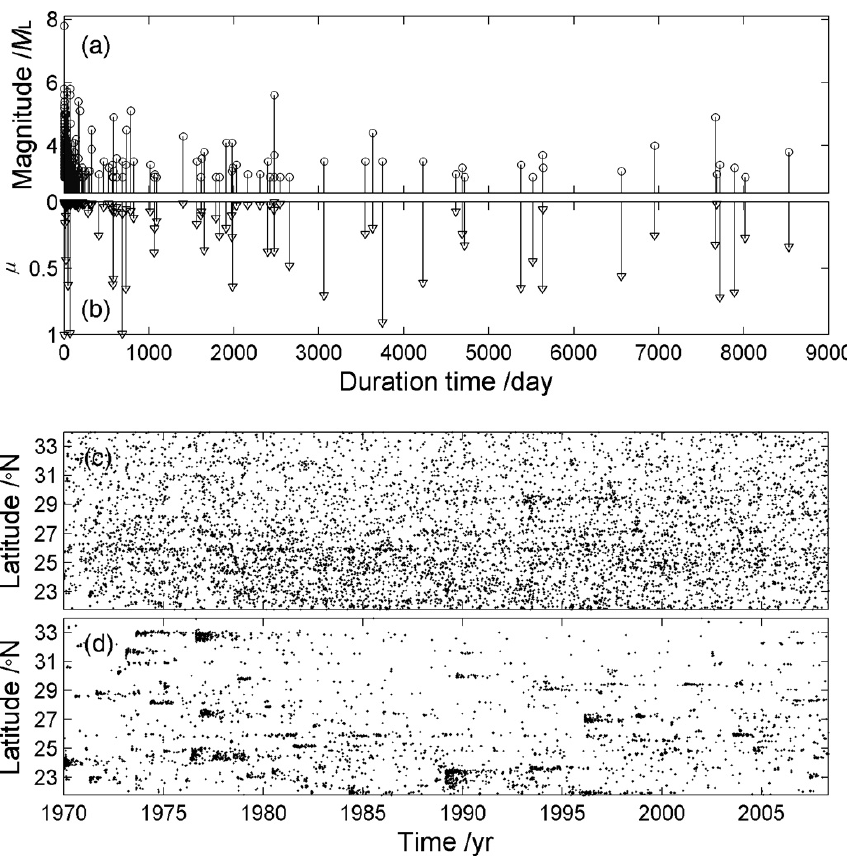
Fig. 2. ETAS de-clustering of earthquake catalogues for the Sichuan-Yunnan region: an example. (a) The M- t plot of the 1970 Tonghai M S 7.8 earthquake and its aftershock sequence. (b) The probability µ for each event to be a “background event”, for the same earthquake sequence as shown in panel (a) . (c) Background events in the Sichuan-Yunnan region since 1970, shown in the coordinate system of time and latitude. (d) Clustering